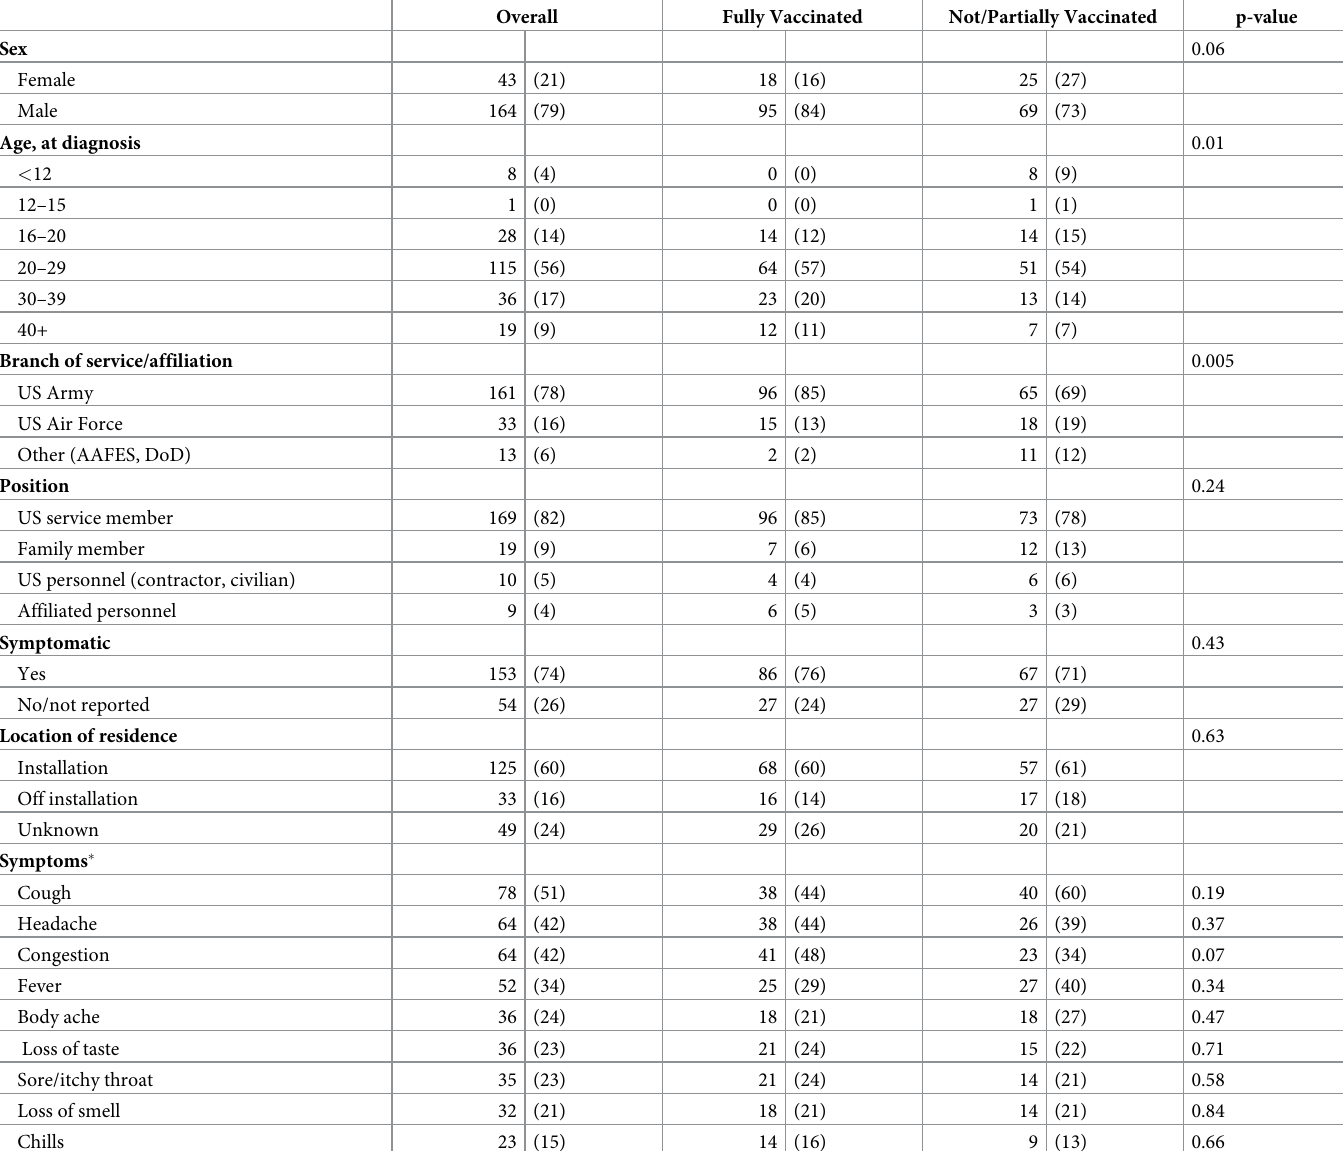
Table 1. Characteristics of 207 outbreak-related cases, overall, and by vaccination status, United States Forces Korea, June 15-July 27,